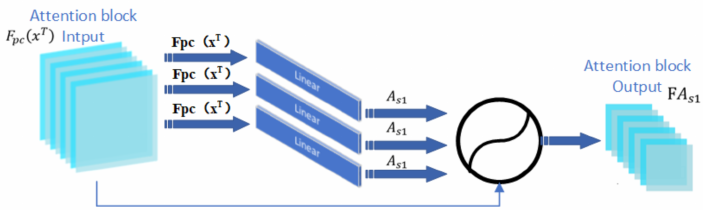
(cid:0) (cid:1) x T is the output of the local and